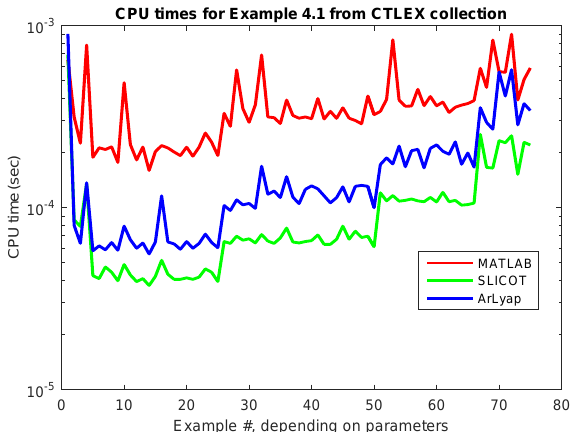
Figure 2. Number of iterations for ArLyap solver, reciprocal condition numbers, and the known solution norms for CTLEX 4.1 series of examples.